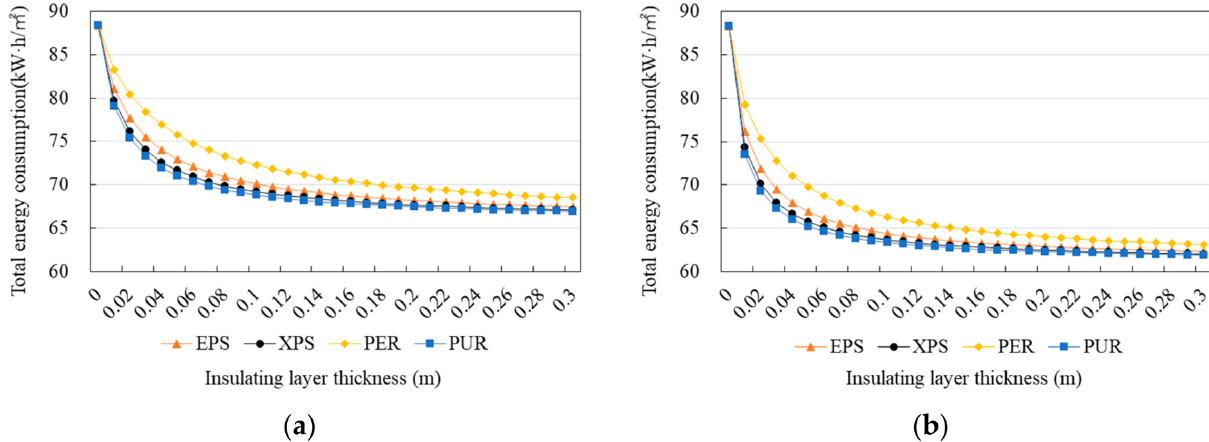
Figure 8. Relationships between insulation layer thickness and total energy consumption: ( a ) external wall; ( b ) roof.